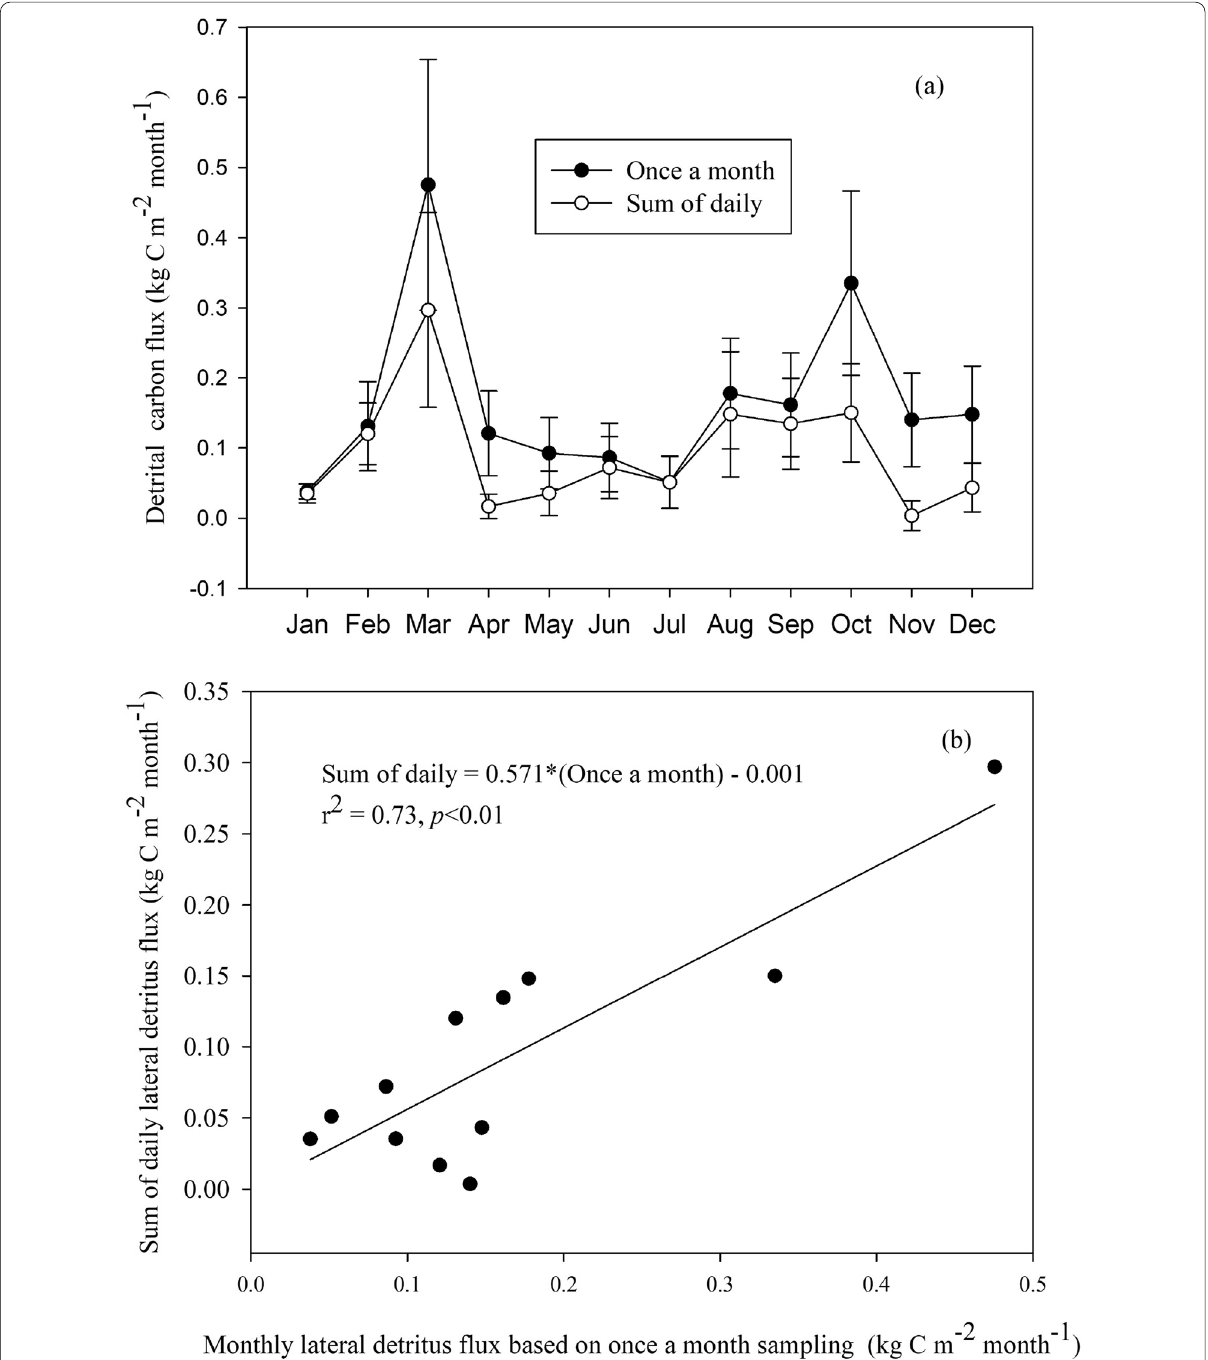
Fig. 4 Comparisons ( a) and the linear relationship ( b) of lateral detritus flux between daily and monthly